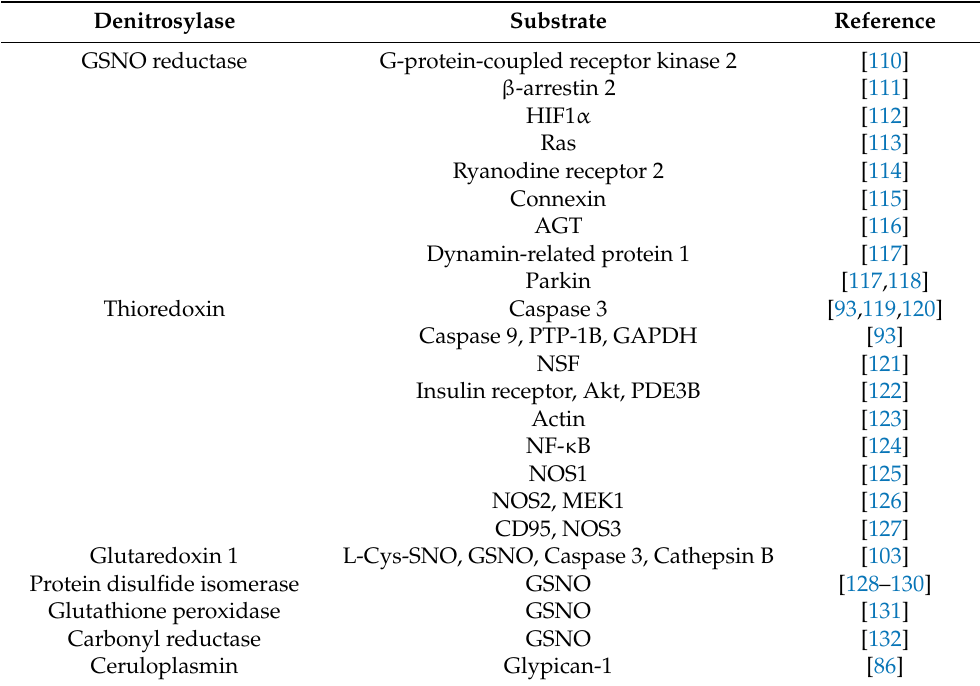
Table 3. The major denitrosylases and their